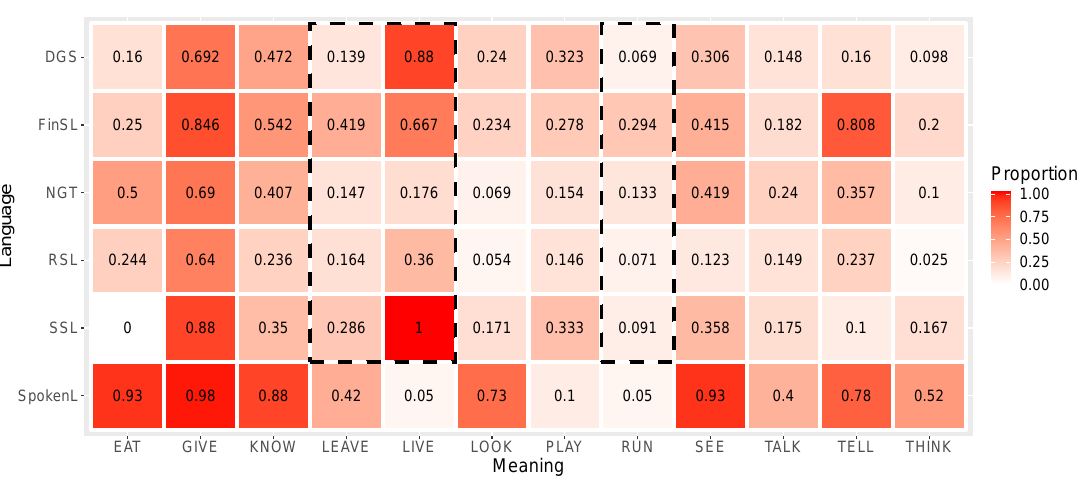
Figure 3: Transitivity prominence for 12 ValPaL verb meanings across five sign languages and the combined spoken languages. Degree of redness indicates the transitivity proportion (darker red corresponds to higher proportions). Values inside the dotted rectangles include locative arguments (verb meanings leave, live, and